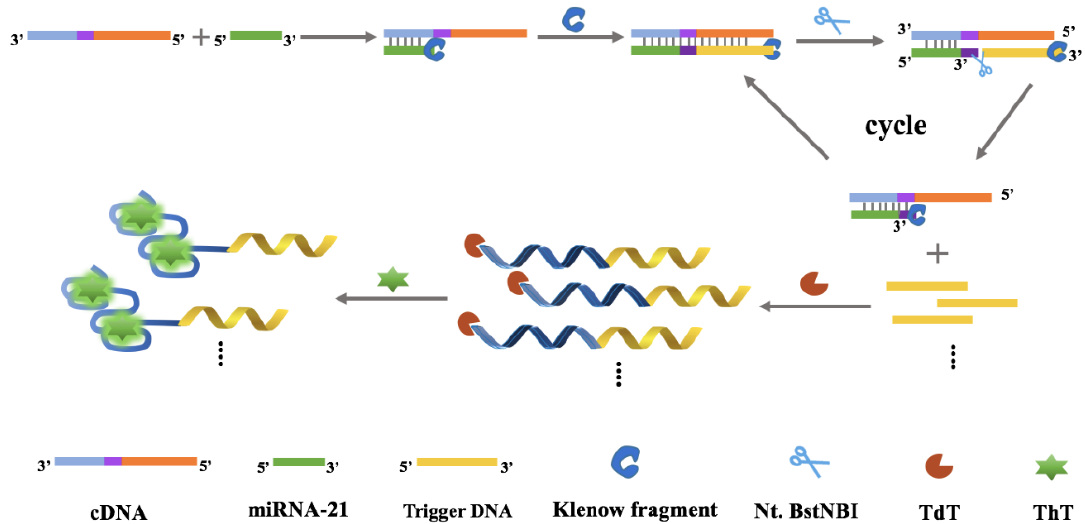
Scheme 1. Schematic of miRNA-21 detection based on isothermal strand displacement amplification strategy and G-quadruplexe-thioflavin T system.